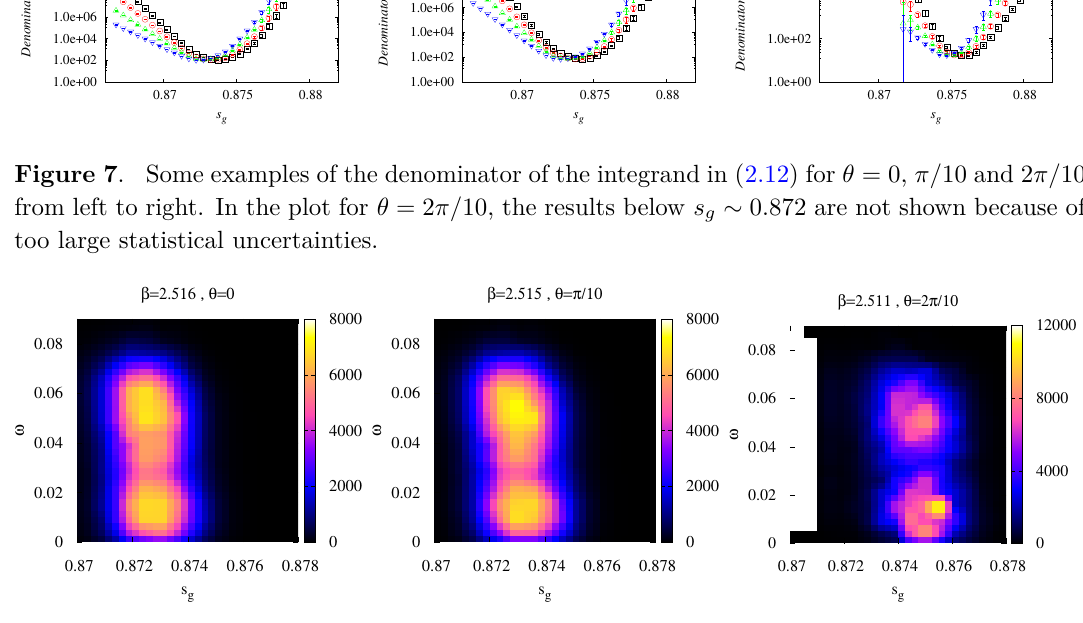
Figure 8 . Examples of the resulting 2-d histogram, p ( s g , ω ; β, θ ) , for θ = 0 , π/ 10 and 2 π/ 10 from left to